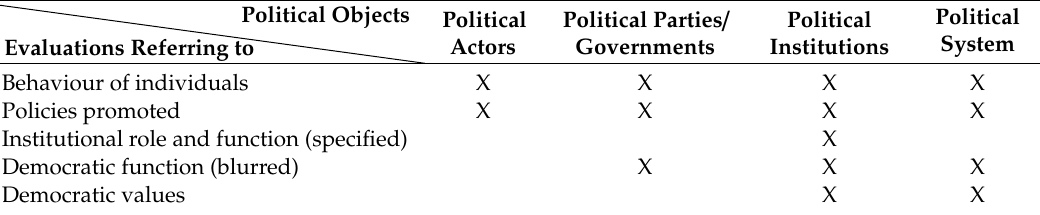
Table 4. Targets of political distrust and their